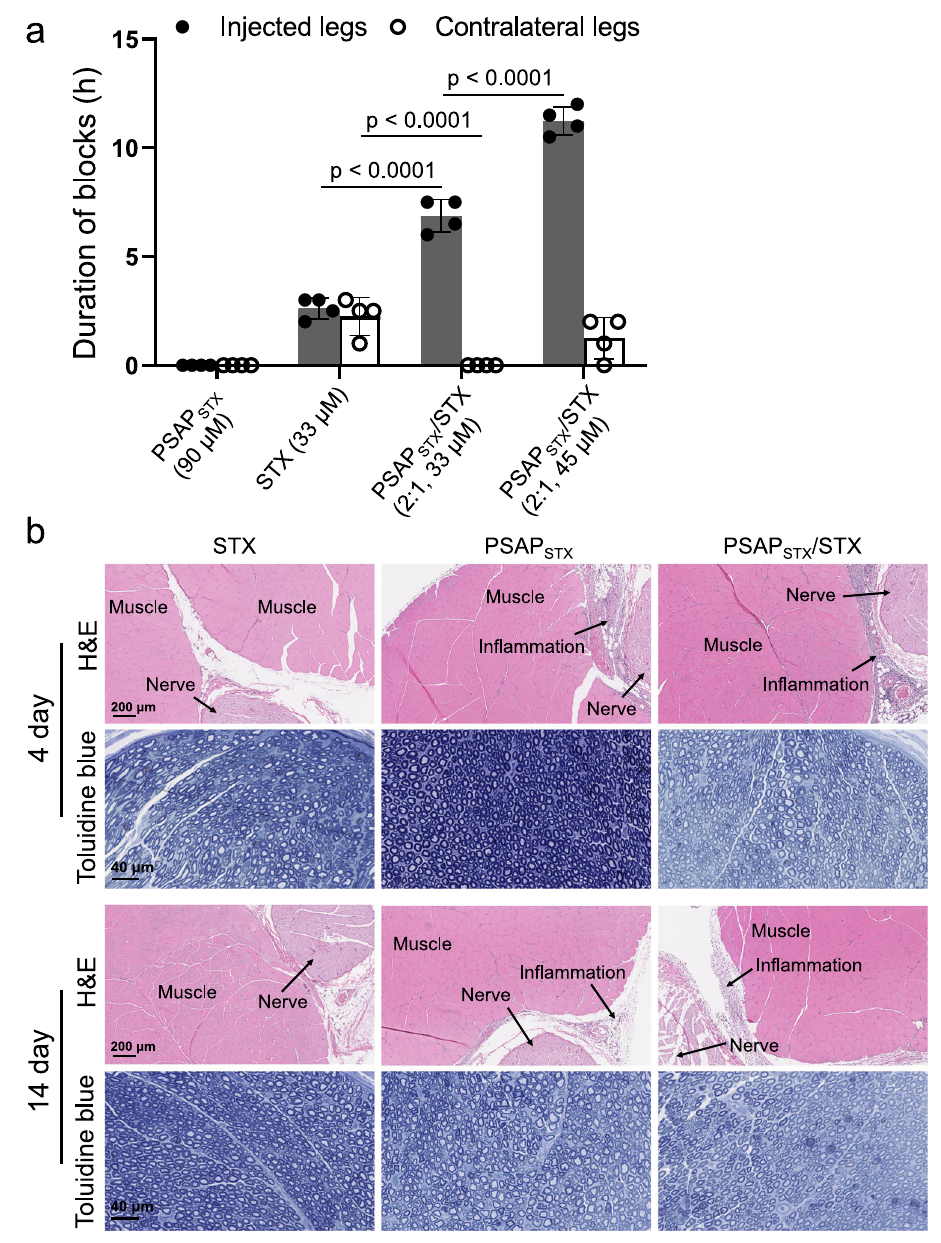
Fig.5|PeripheralnerveblockadeeffectofSTX-bindingPSaptamer(PSAPSTX)/ STX. a Duration of sensory nerve blocks in the injected legs and uninjected (con- tralateral) extremities after sciatic nerve injection ( n =4 biologically independent animals). Data are means±s.d. Statistical comparisons were performed using